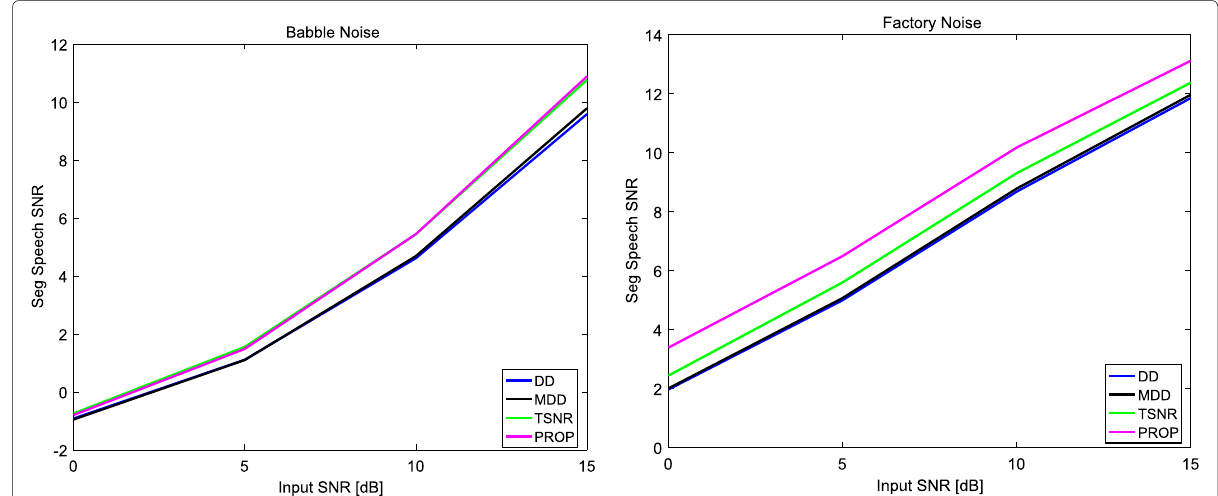
Fig. 5 Speech distortion measure for noisy speech corrupted with different noise types and under different SNR levels enhanced by Wiener filter speech estimation technique